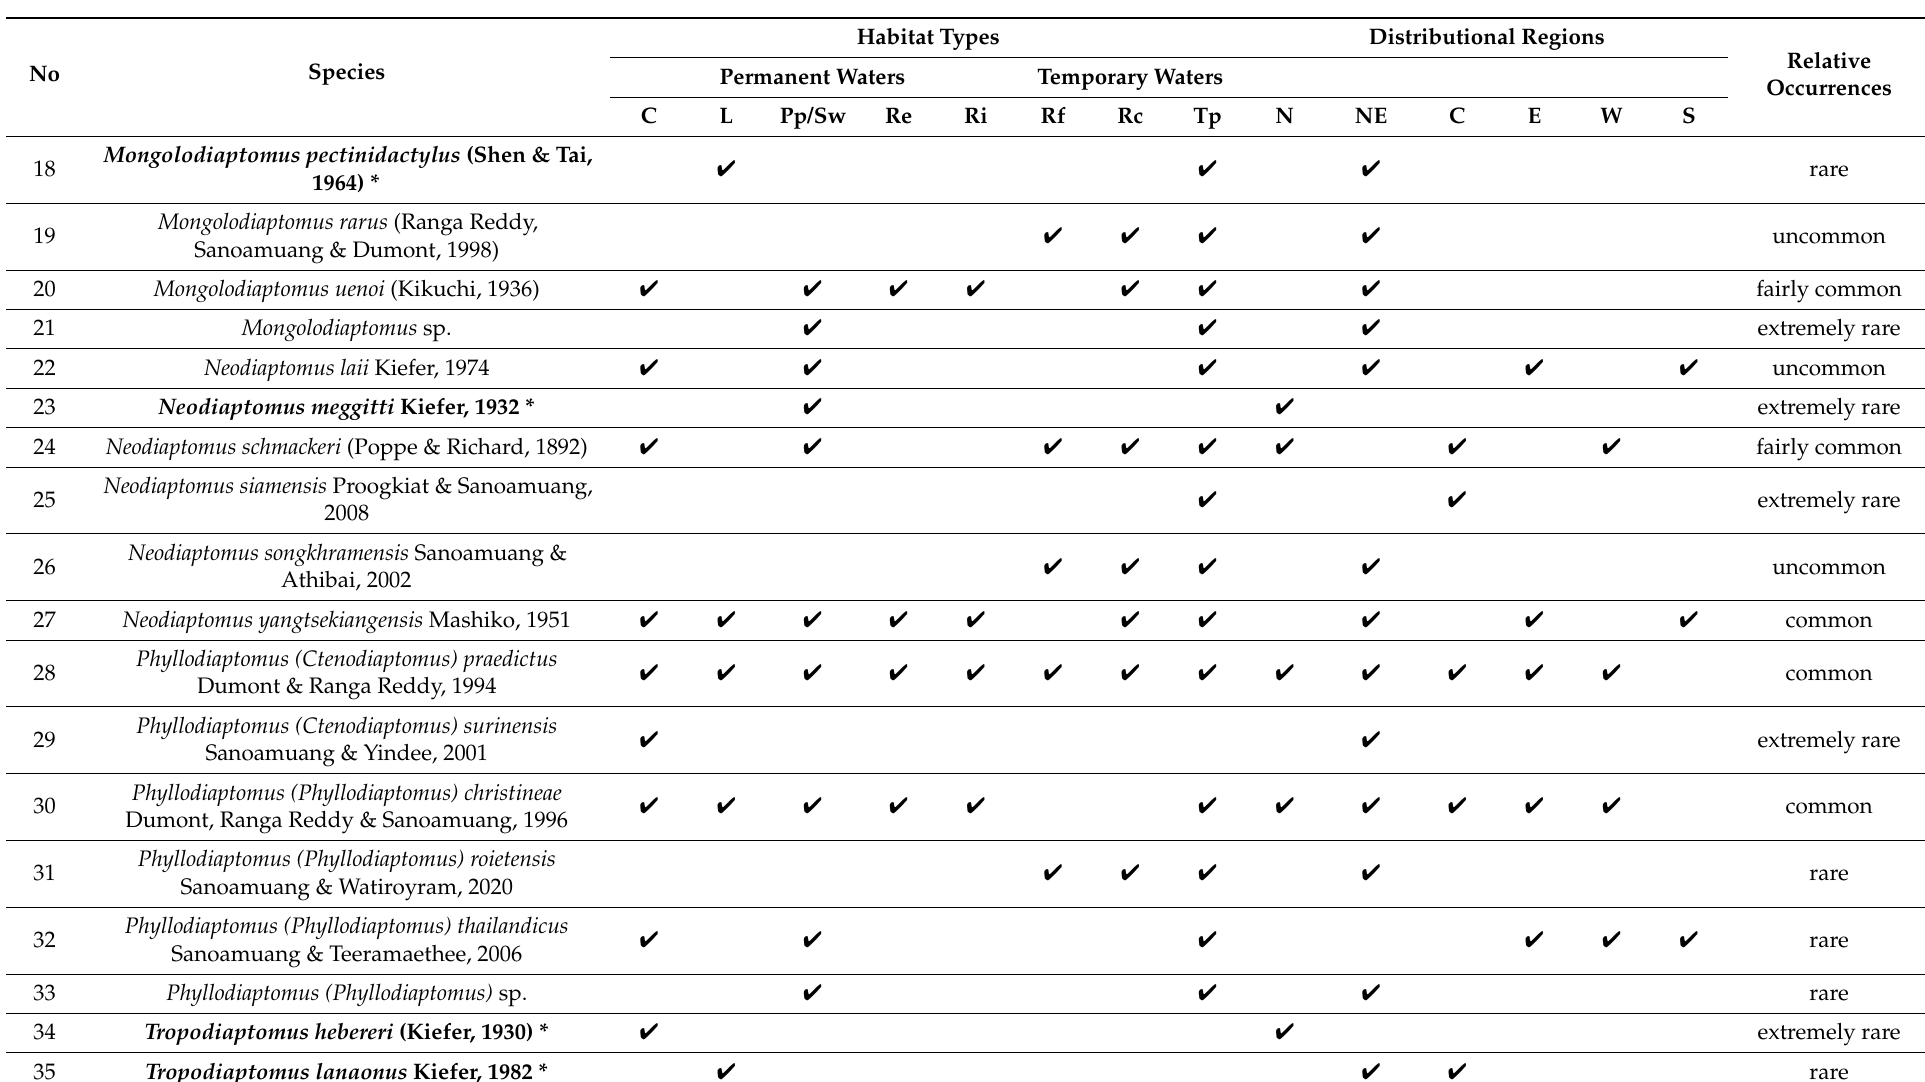
Table 2. Cont. Habitat